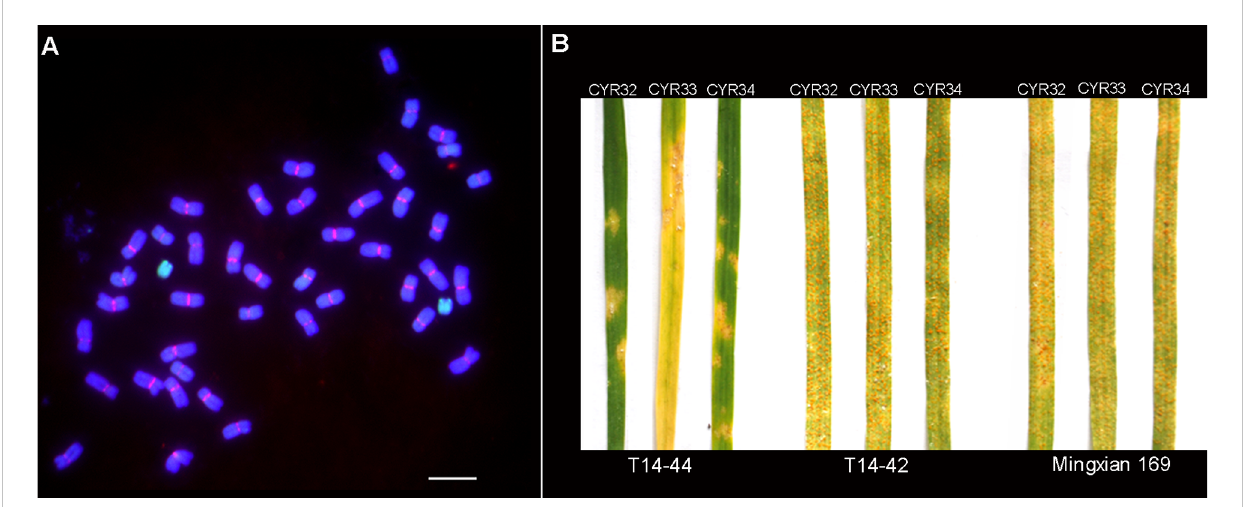
FIGURE 1 TAI-14 karyotype and its stripe rust resistance. (A) T14-44 karyotype identi fi ed by genomic in situ hybridization (GISH) and fl uorescence in situ hybridization (FISH). The genomic DNA of Th. intermedium (green) and the wheat centromeric retrotransposon 6C6 (red) were used as a probe. The genomic DNA of Chinese Spring (CS) was used as a blocker. Chromosomes were stained with 4, 6-diamidino-2-phenylindole (DAPI; blue). Scale bar = 10 m m. (B) Stripe rust evaluation on T14-44 and T14-42. Stripe rust tests were performed using three rust races CYR32, CYR33, and CYR34, respectively. Common wheat cultivar Mingxian 169 was used as the susceptible